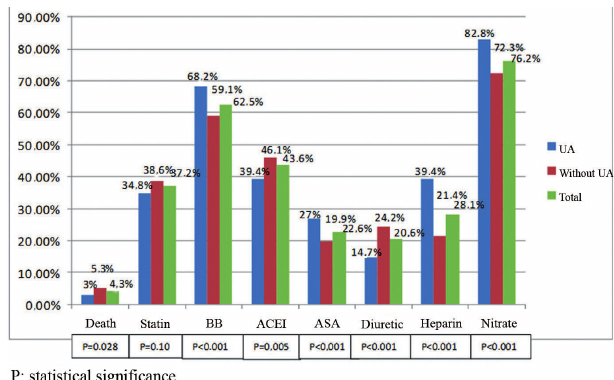
Fig. 1 - Rates of death, use of statins, beta-blockers (BB), angiotensin converting enzyme inhibitors (ACEI), acetylsalicylic acid (ASA), diuretic, Heparin (heparin) and nitrate in patients with unstable angina (UA) and without preoperative surgical myocardial revascularization. Analysis of the period between 1996 - 2003, total of 1799